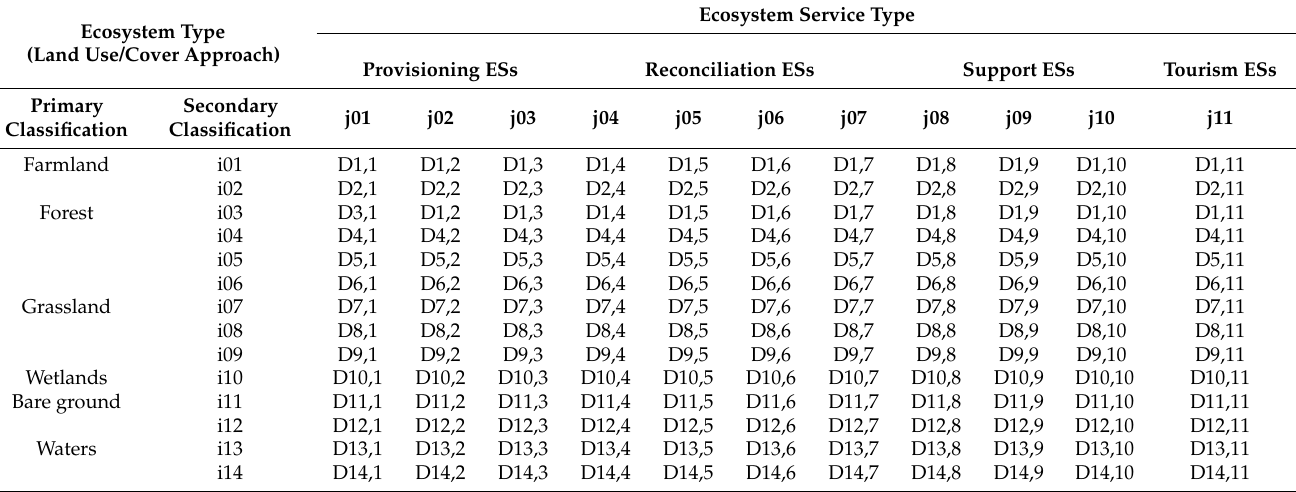
Table 1. Composition of GEP and its accounting